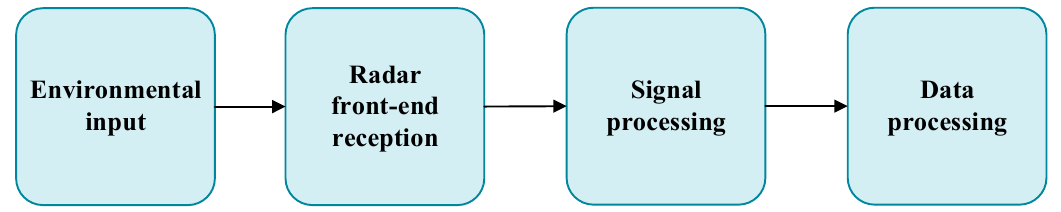
Figure 9. The four stages of the analysis of radar effect mechanism.